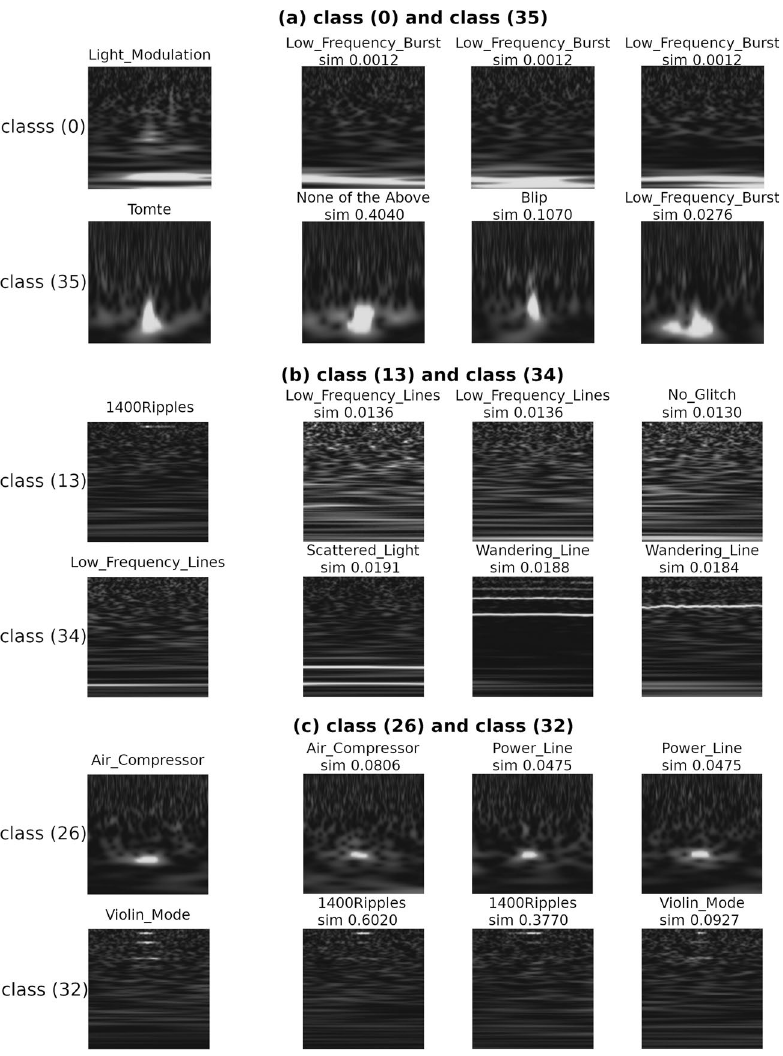
Figure 6. Examples of images in the classes with reduced accuracy in unsupervised learning. The major images in the left column are randomly sampled data from class ( i ). The minor images in the other columns are sorted in an ascending order from the cosine similarity to its major image, indicating that they are sampled from the lowest similarity to the major one. The Gravity Spy label and the value of the cosine similarity are on top of the sampled